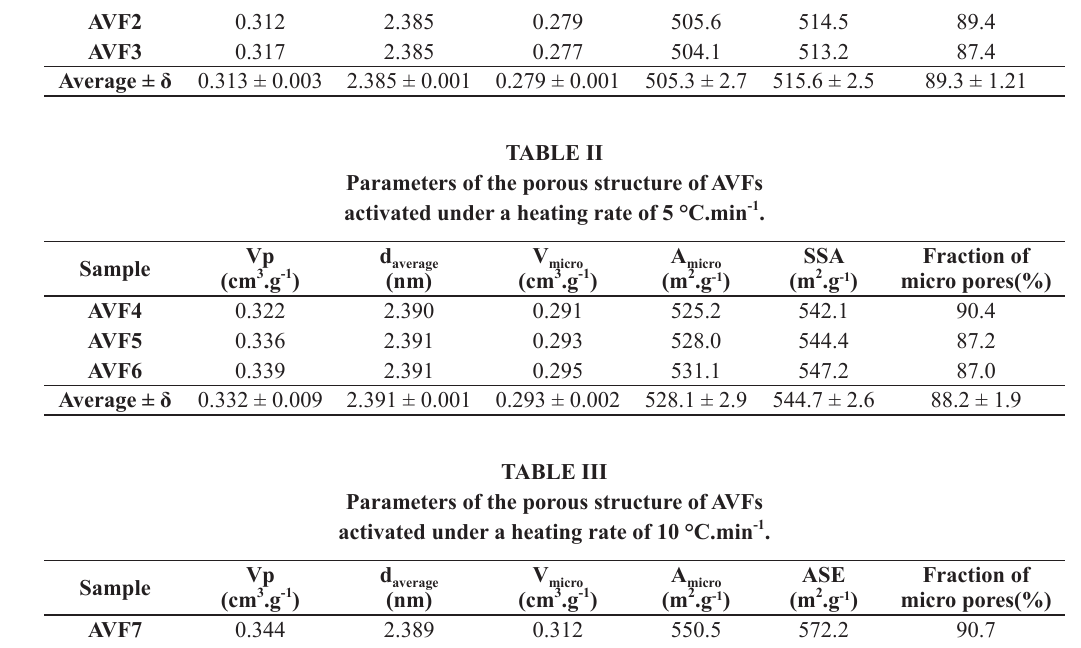
Fraction of micro pores (%)